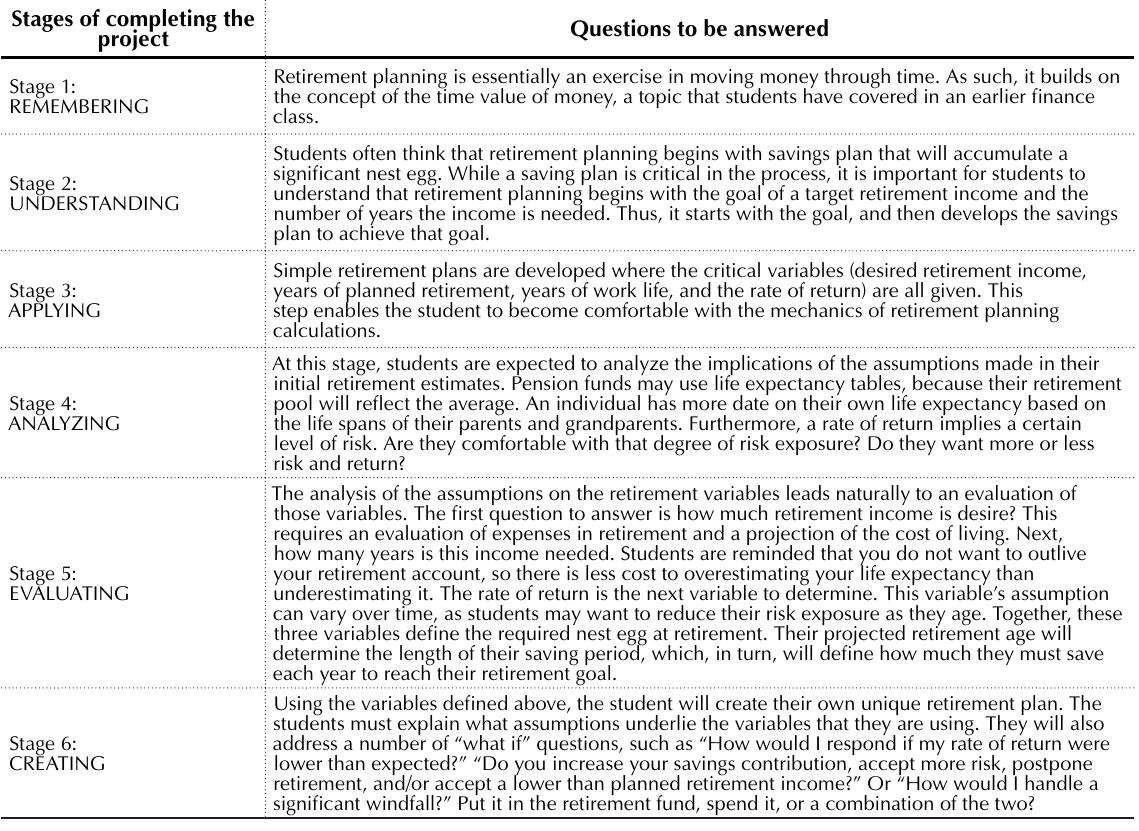
Table D2. Stages of completing the